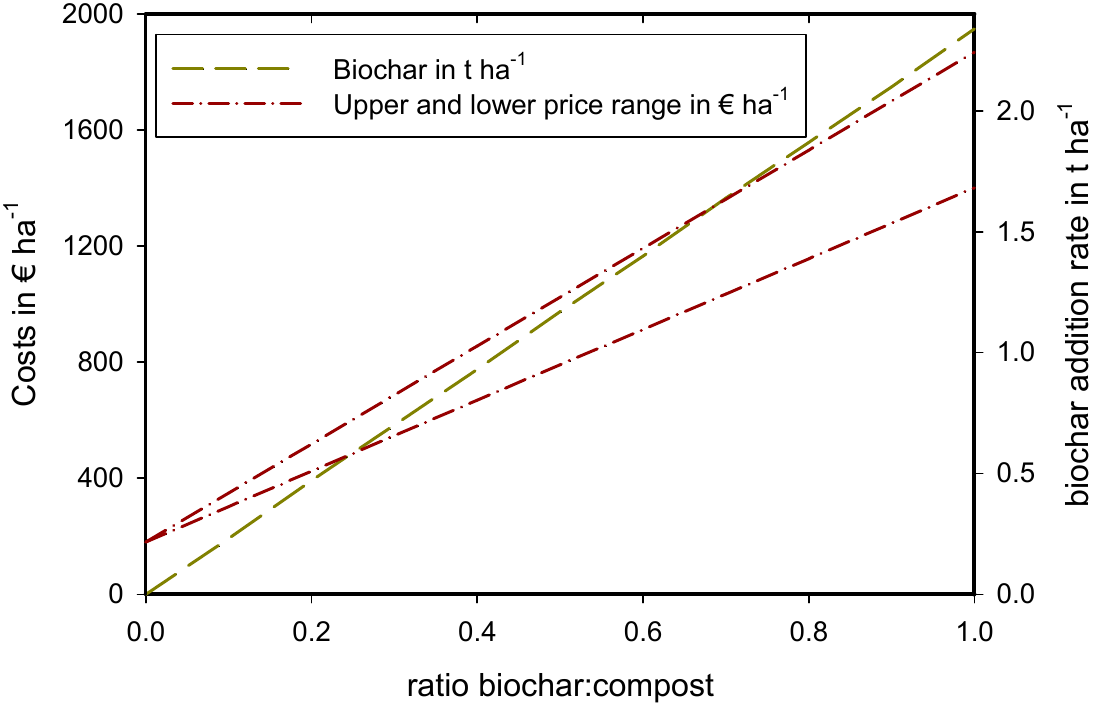
Figure 5. Average costs for C sequestration according to the 4 per mille objective on all Austrian crop areas, vineyards and orchards for BC–compost ratios from 0/1 to 1/0.